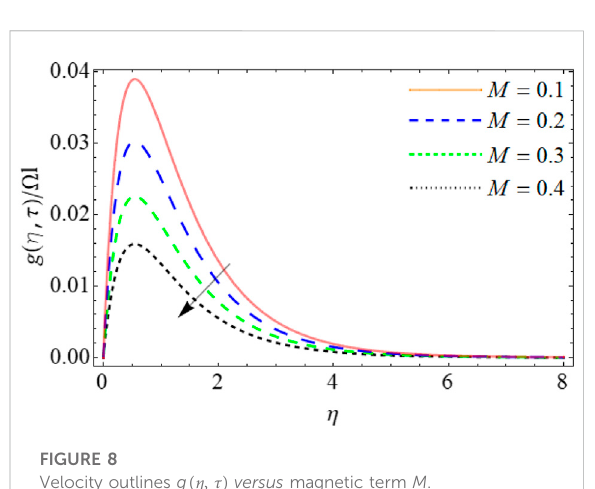
FIGURE 8 Velocity outlines g ( η , τ ) versus magnetic term M .